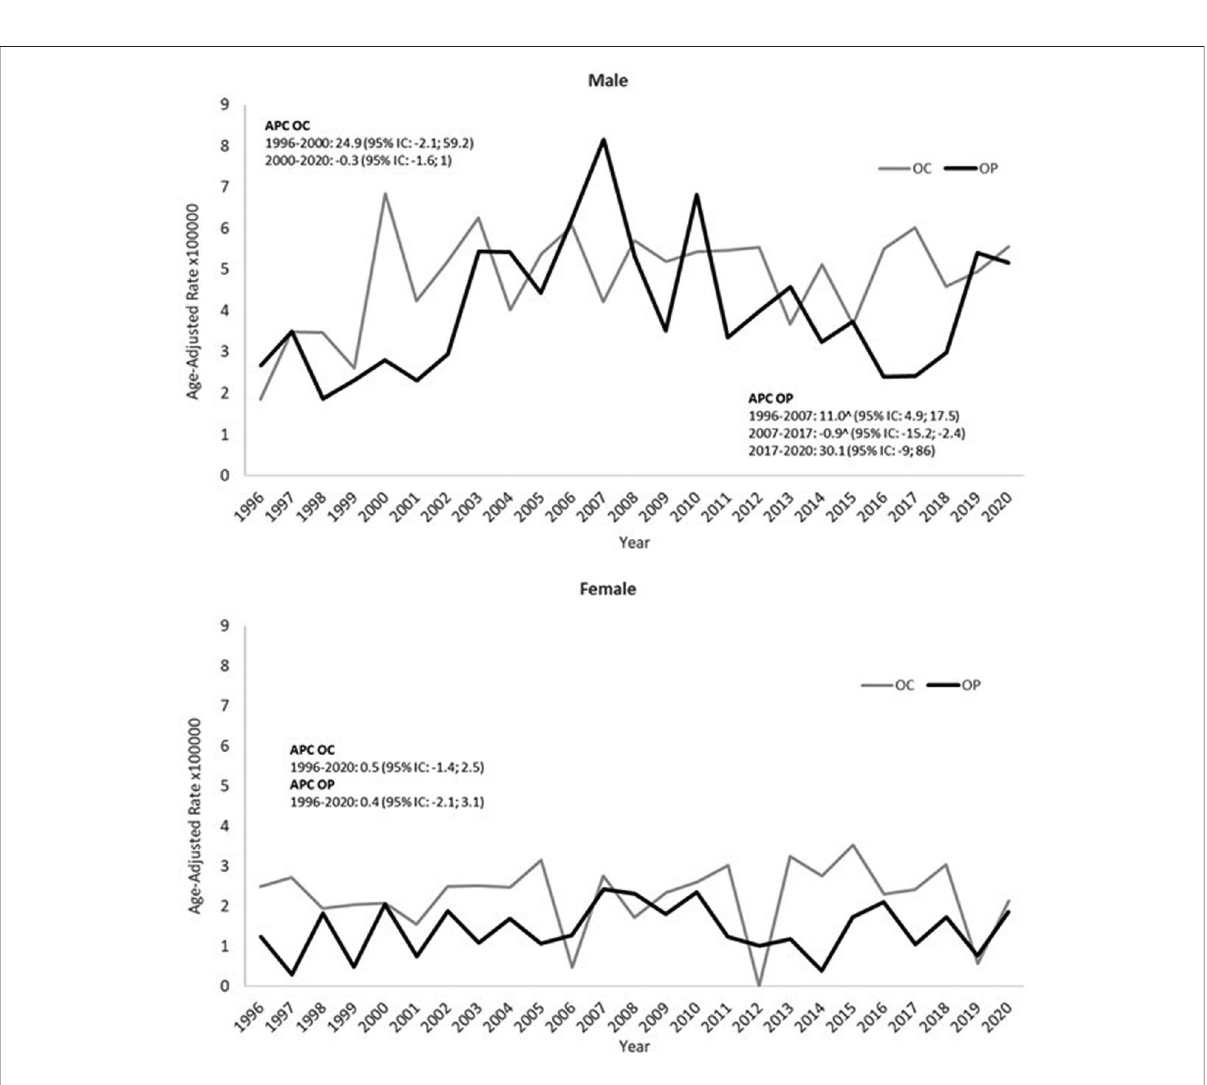
FIGURE 1 Trends in European age-standardized incidence rates of oral cavity cancer (OC) and oropharyngeal cancer (OP), males and females (1996 – 2020).